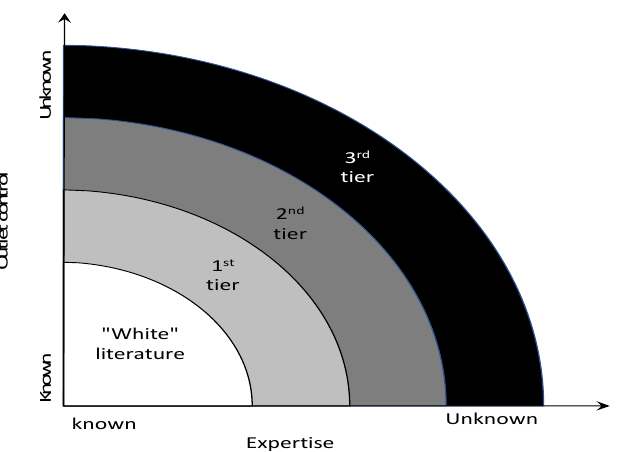
Figure 1. Different types of literature used in software engineering; adapted from Garousi et al.